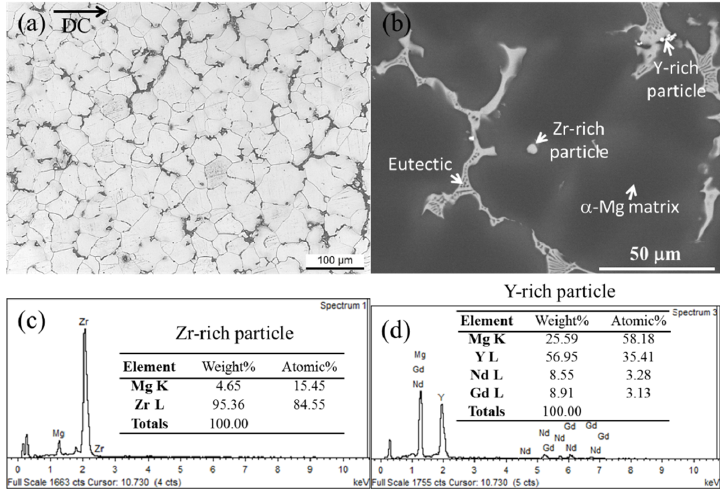
Figure 1. Typical ( a ) optical microscopy (OM) and ( b ) scanning electron microscopy (SEM) microstructures of the as-cast (AC) WE43 alloy with EDS analysis of Zr-rich and Y-rich particles in ( c ) and ( d ), respectively. The direct-chill casting direction (DC) is horizontal in picture ( a ). Metals 2020 , 10 , x FOR PEER REVIEW The as-extruded Ex-1 microstructure has a bimodal grain structure, which consists of fine equiaxed grains and coarse elongated grains along the extrusion direction (ED) (Figure 2). The fine grains have an average diameter of 15 2.4 m and the coarse elongated grains have a length of 150- 400 m and a width and thickness of about 20 m. The volume fraction of the coarse elongated grains is no more than 28%. The bimodal grain structure is formed due to an occurrence of partially dynamic recrystallization (DRX) during hot extrusion. The coarse elongated grains are not recrystallized and formed from the as-cast grains under the material flow along the ED. Through fully DRX, the as- extruded Ex-2 microstructure has a relatively uniform fine grain structure and the average diameter is 10 2.3 m (Figure 3). Both the Ex-1 and Ex-2 microstructures contain a large number of fine intermetallic particles and most of them are aligned in the ED, which leads to the formation of particle strips (Figures 2 and 3). The intermetallic particles have been identified as Mg 24 Y 5 phase and equilibrium phase by Kubásek et al. [26]. We consider that the cuboid Mg 24 Y 5 particles come from the as-cast microstructure because they are not dissolved during solution treatment. Besides, the fine Zr-rich particles with a small volume fraction also remain in the microstructure after solution treatment. In particular, a high density of very fine particles is within the interior of coarse elongated grains (Figure 2e). Furthermore, the grains with the particle strips have a smaller size than that without the particle strips (Figures 3c and d). This implies that the intermetallic particles hinder the grain growth.